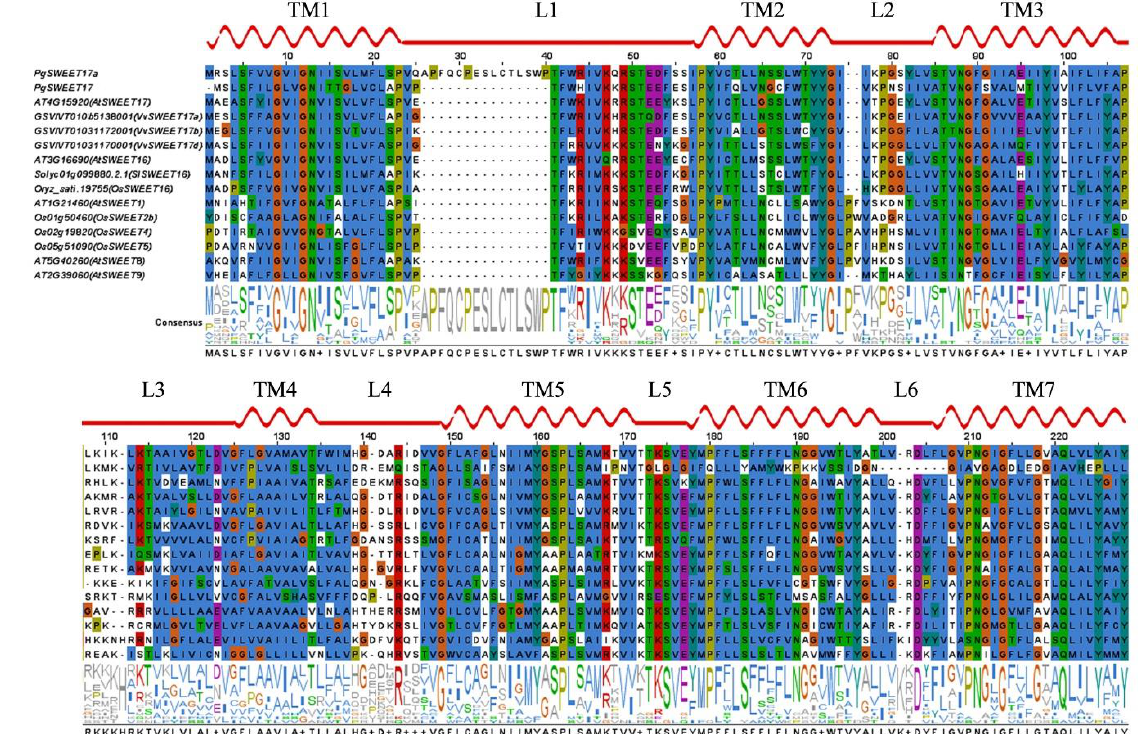
Figure 7. Sequence alignment of SWEET proteins.